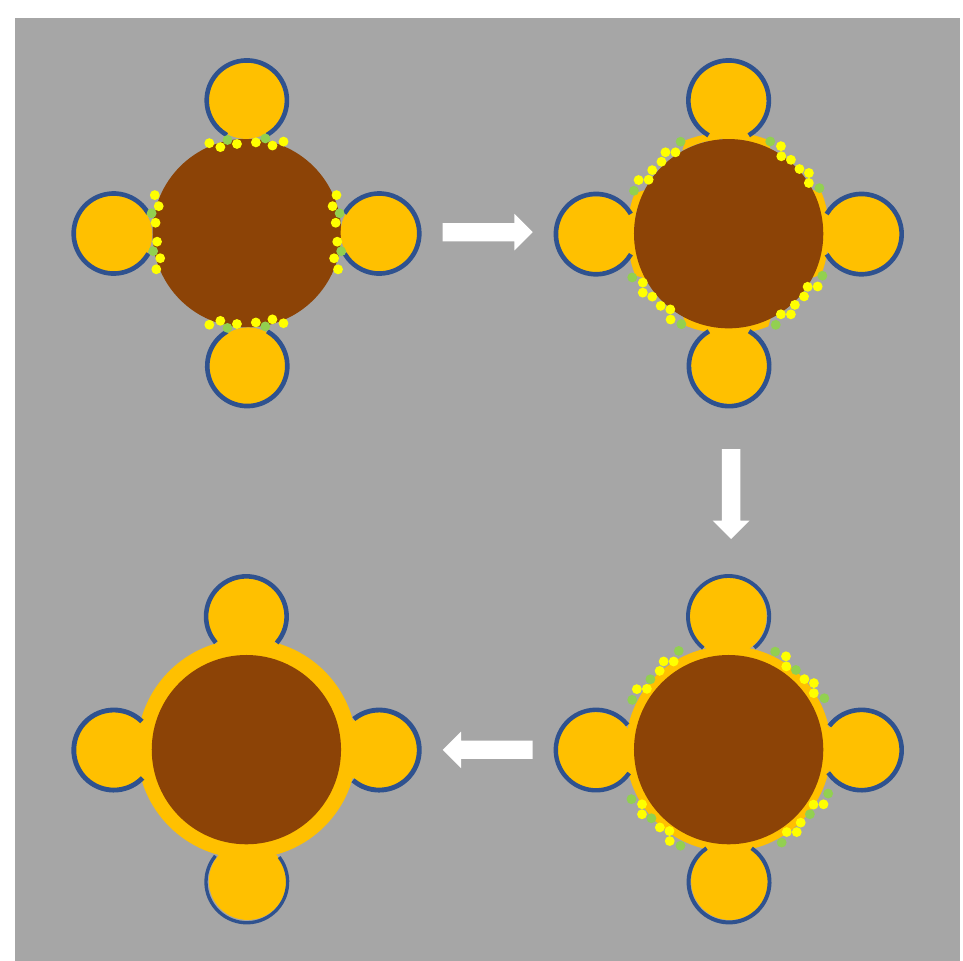
Figure 5. Proposed mechanism of gold growth by seeding method in gold-decorated nickel ferrite nanoparticles. The brown circles represent NiFe 2 O 4 clusters; orange circles represent gold nanoparticles; the blue layer represents the tetraoctylammonium bromide (TOAB) molecules layer; small yellow circles are AuCl 4 − molecules; small green circles are hydroxylamine molecules.